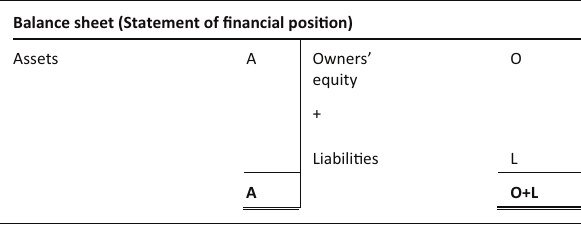
FIGURE 14: Statement of financial position.